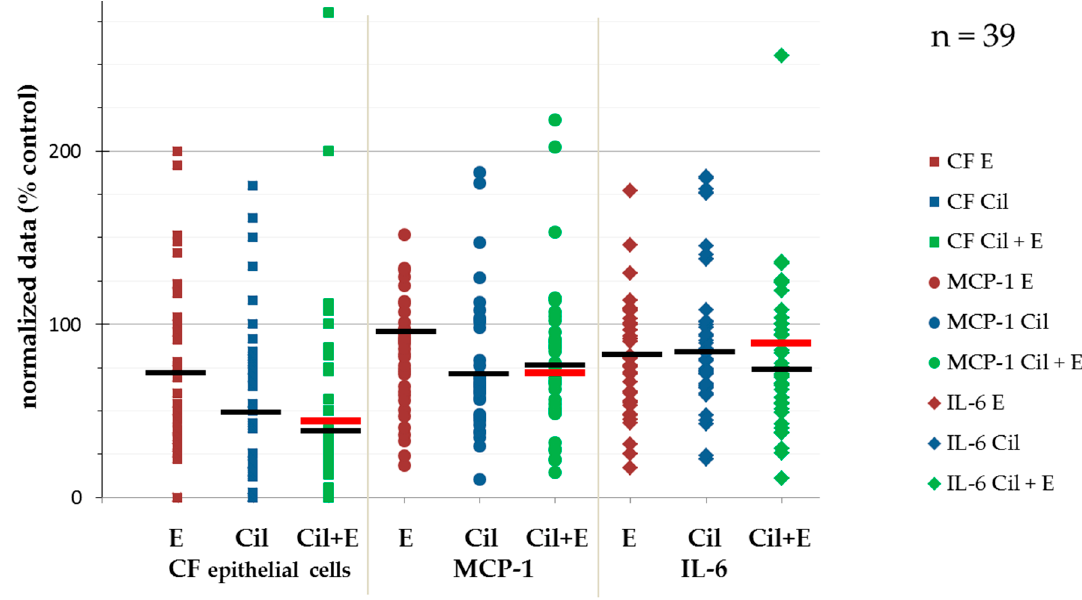
Figure 1. Heterogeneity in response of 39 HNSCC in the FLAVINO assay according to the readouts of colony formation (CF), release of MCP-1, and interleukin 6. Black lines represent median values, red lines represent cutoff values identified in receiver operator characteristic (ROC) analyses (Figures S1–S3). Abbreviations: CF, colony formation; IL-6, interleukin 6; MCP-1, monocyte chemotactic protein-1; Cil, cilengitide; E, Erbitux (cetuximab); Cil+E, cilengitide combined with Erbitux (cetuximab).